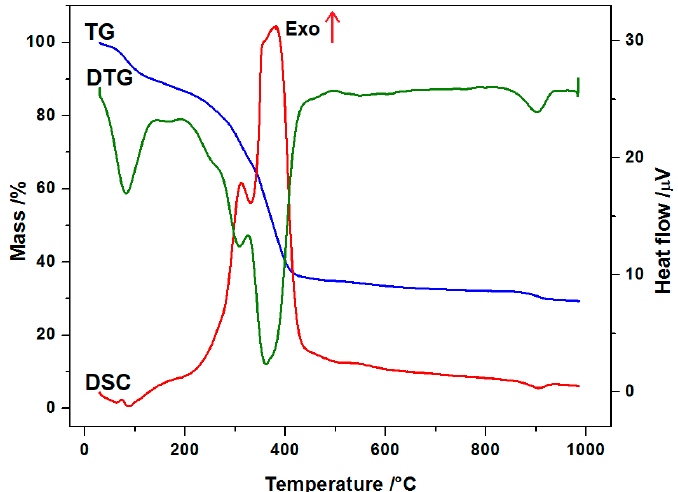
Figure 4. Thermogravimetric (TG), differential thermogravimetric (DTG) and differential scanning calorimetric (DSC) curves of the thermal decomposition of complex Pd II –Er III –Pd II ( 3 ) in air (Exo–exoenergetic effect).